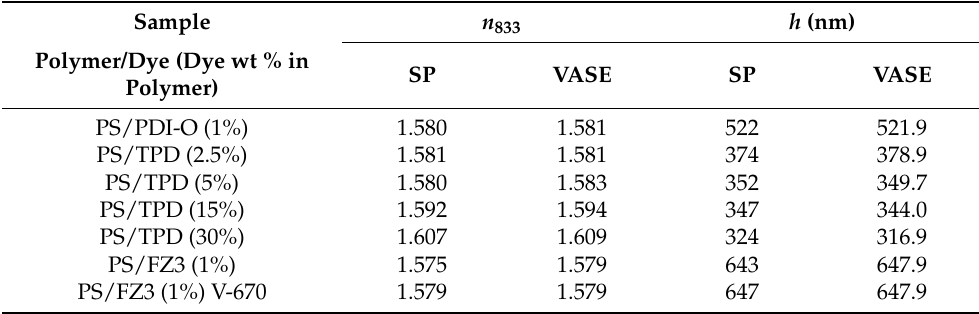
Table 4. Comparison of n and h of dye-doped PS films, obtained with the proposed spectrophotomet- ric method (SP) and with VASE. The fitting for PDI-O and TPD was made in the range of 600–850 nm, and FZ3 was fitted in two ranges: 750–850 nm and 750–1500 nm (using data from the Jasco V-670 UV-VIS-NIR